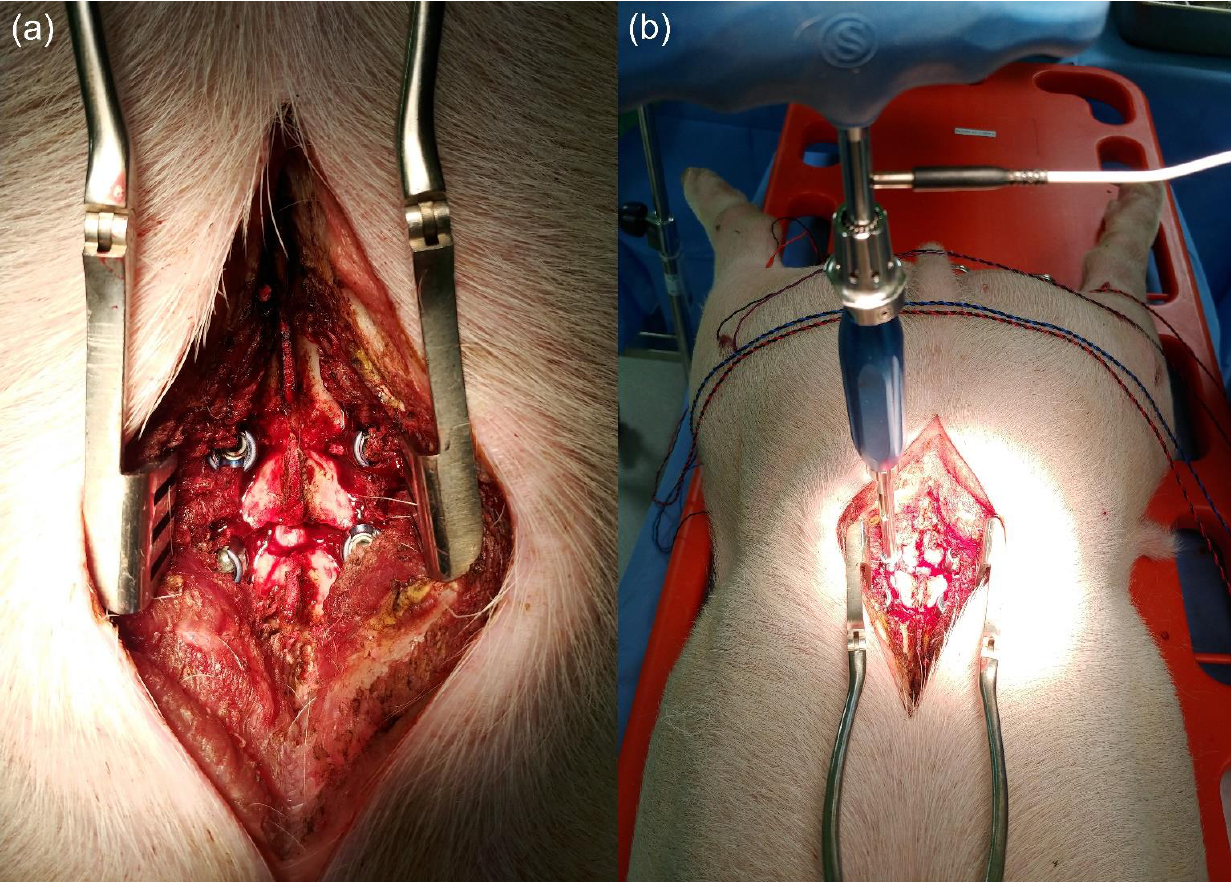
Figure 5. Intraoperative photographs. ( a ) Four inserted pedicle screws at pedicles of 4th and 5th lumbar vertebrae. ( b ) Triggered electromyography setting using magnetic nerve stimulator.